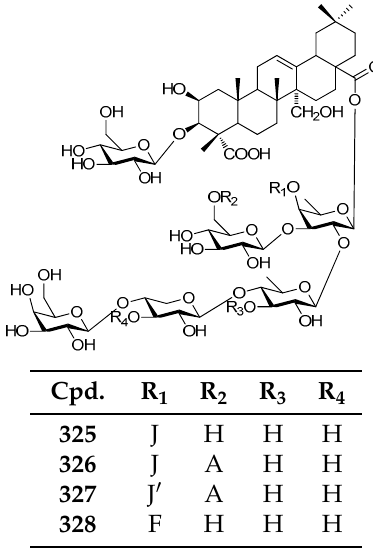
Cpd. Figure 66. Structures of compounds 323 – 324 . Figure 66. Structures of compounds 323 – 324 . Figure 66. Structures of compounds 323 – 324 .